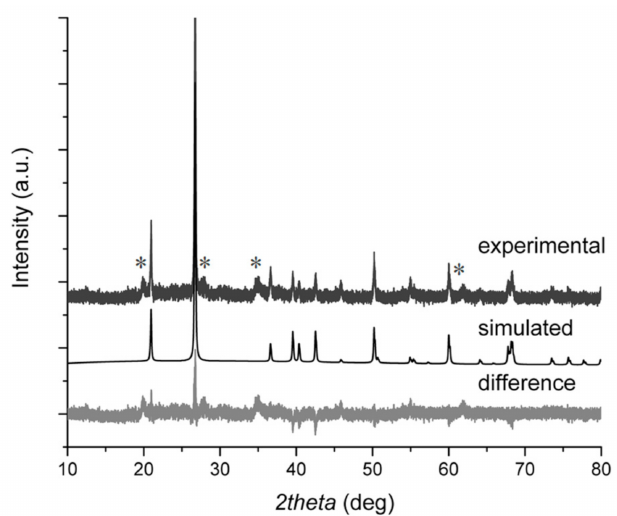
Figure 4. Rietveld fit for the XRD spectrum of the studied mercury-contaminated soil using the crystal structure of alpha-quartz (“simulated”). “Difference” curve represents the difference between “experimental” and “simulated” using alpha-quartz as the only phase. Some additional unidentified reflections are marked with